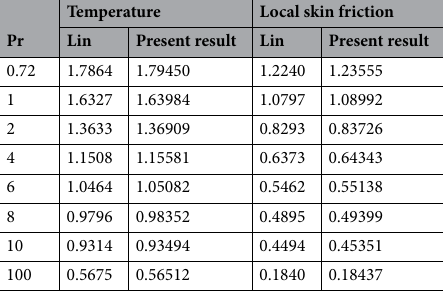
Table 2. Temperature and local skin friction at steady state X = 1.0 compared with Lin 43 at uniform surface heat flux, n = 0, M = 0.